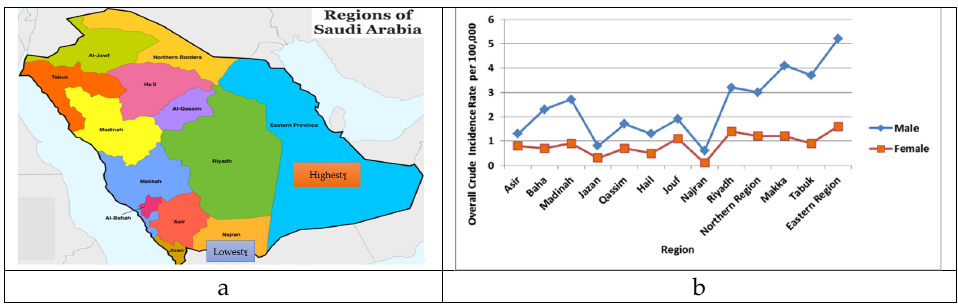
Figure 5. ( a ). Lung cancer and its incidence in different regions of Saudi Arabia: CIR by Geographical regions in Saudi Arabia. Source: https://www.geocurrents.info/cartography/customizable-maps-iran-saudi-arabia-malaysia-indonesia/attachment/regions-of-saudi-arabia-map. ( b ): Overall CIR of lung cancer cases per 100,000 among males and females according to administrative regions during 2006 to 2016.